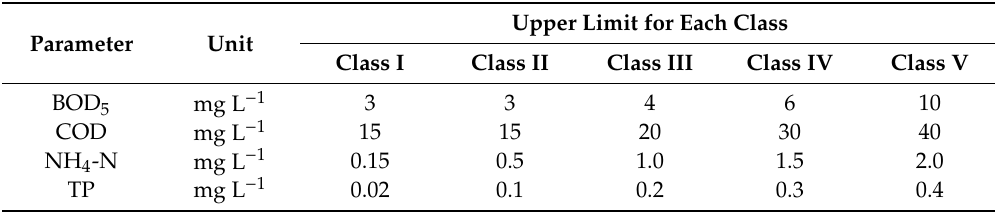
Table 2. Environmental Quality Standards for Surface Water of the People’s Republic of China for water quality parameters in this